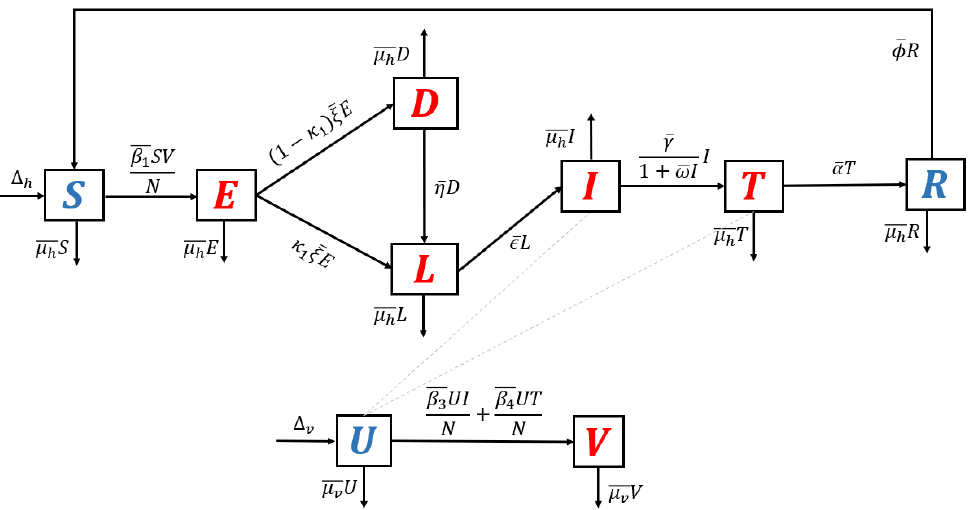
Figure 6. Transmission diagram of malaria disease with relapse only, without reinfection and